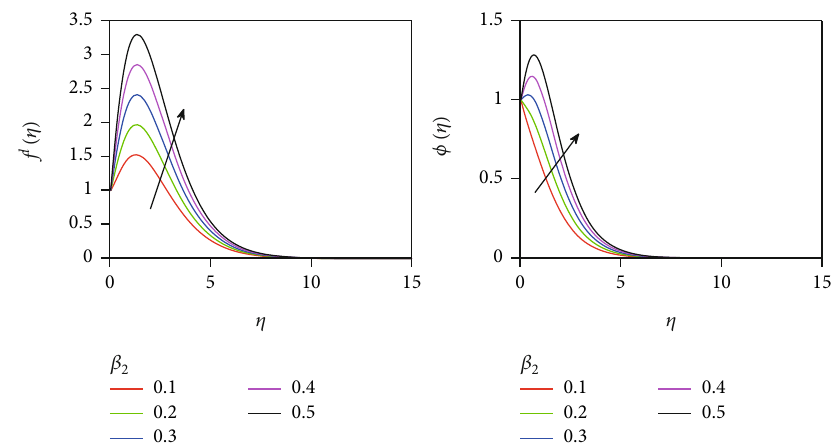
Figure 15: Signi fi cance of the mass fl ux relaxation parameter on velocity and concentration plots.